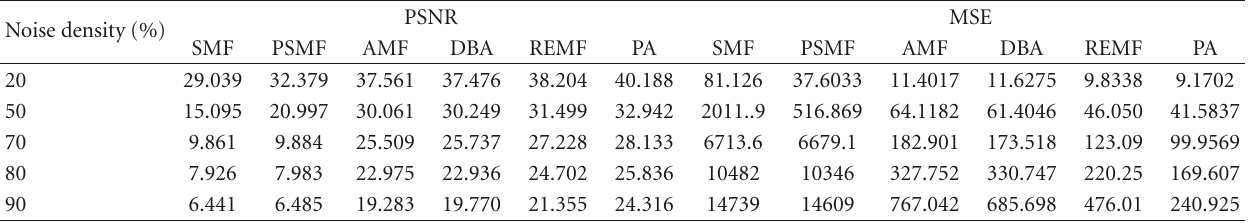
Table 1: PSNR and MSE for various filters for Lena image at di ff erent noise densities.